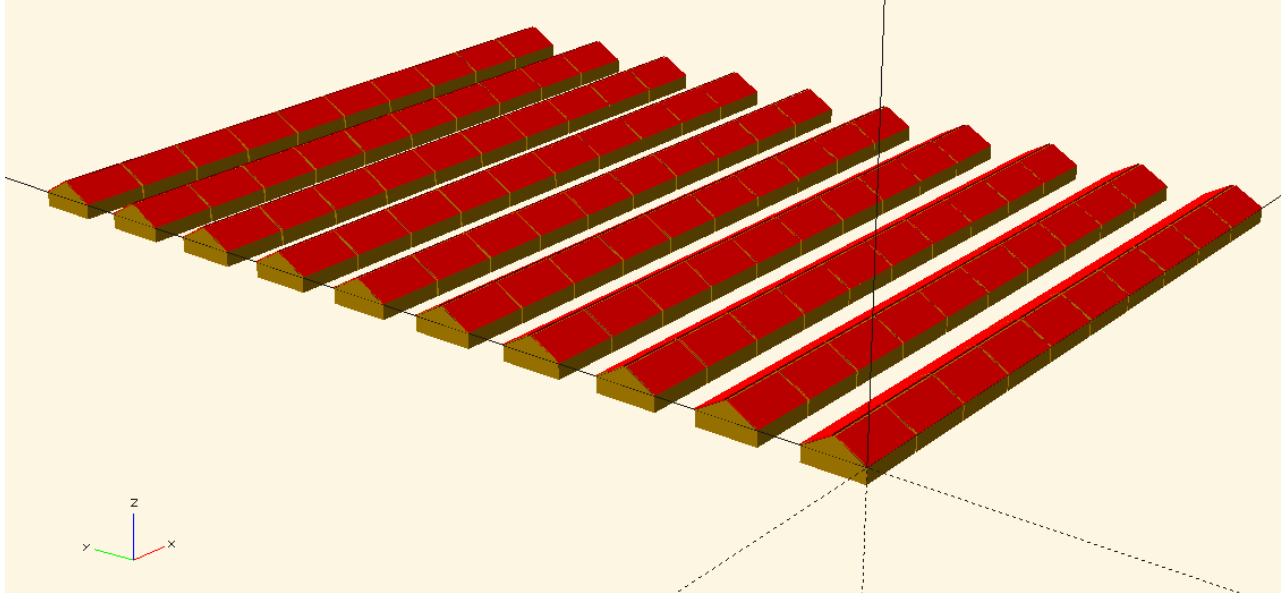
Figure 10. Array of double POSCAS facing E-W with tilt angle of 30 degrees.